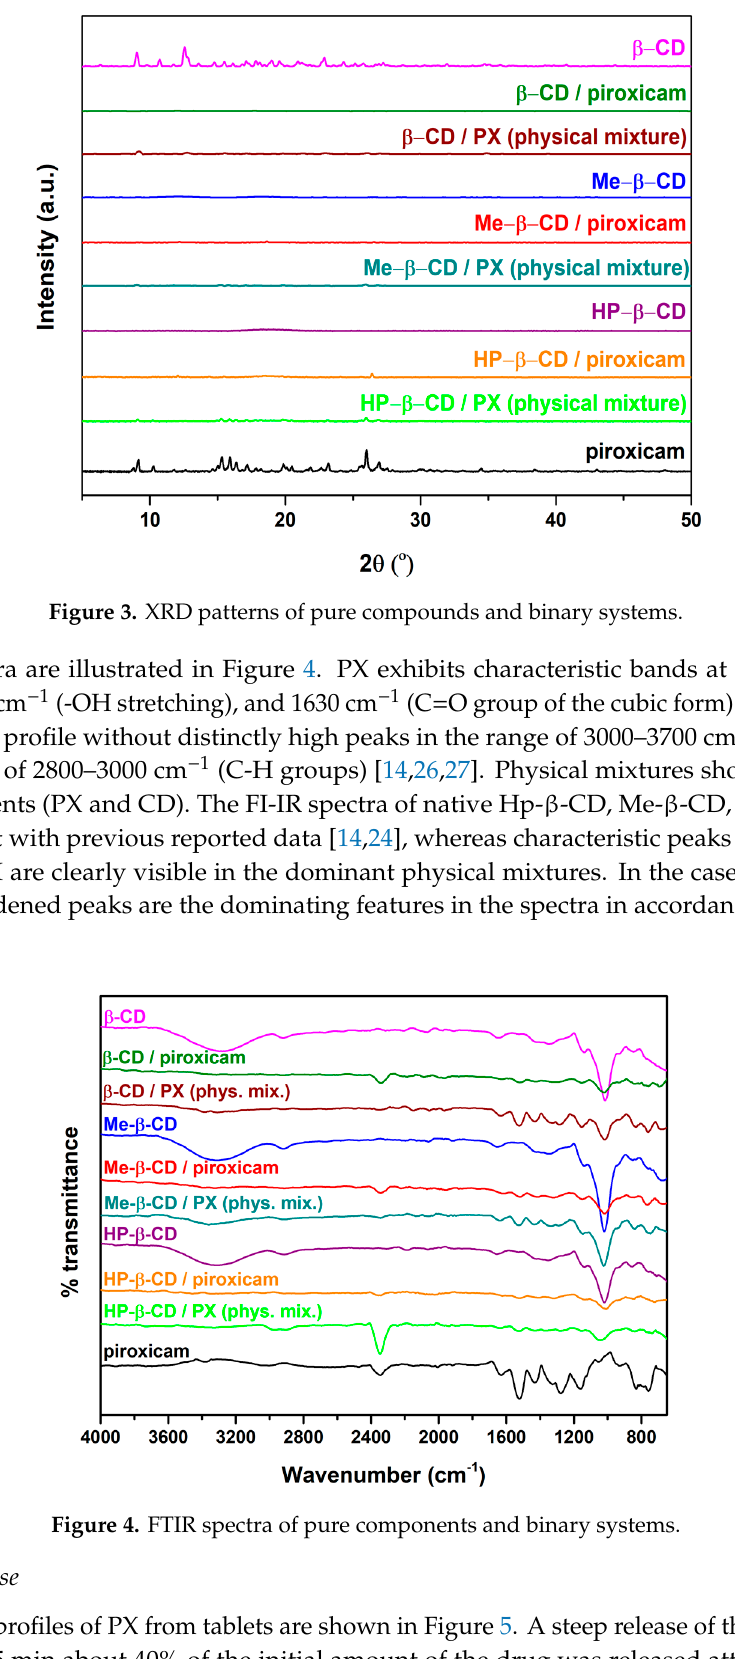
Figure 5. In vitro release studies of pure piroxicam and binary systems in tablet form ( n = 3).